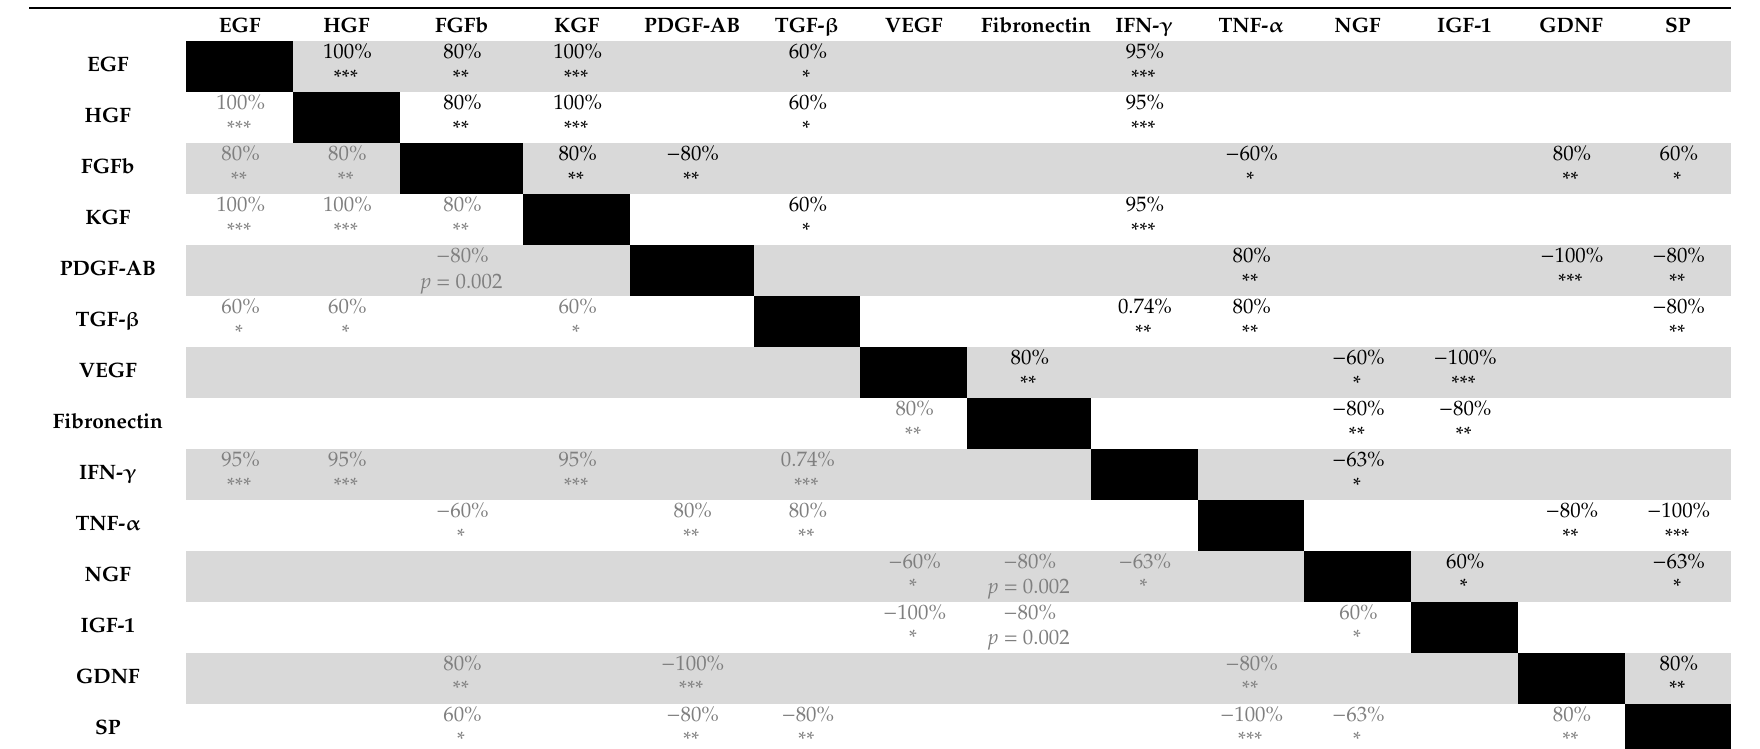
Table 3. Correlations between human sera’s growth factors and